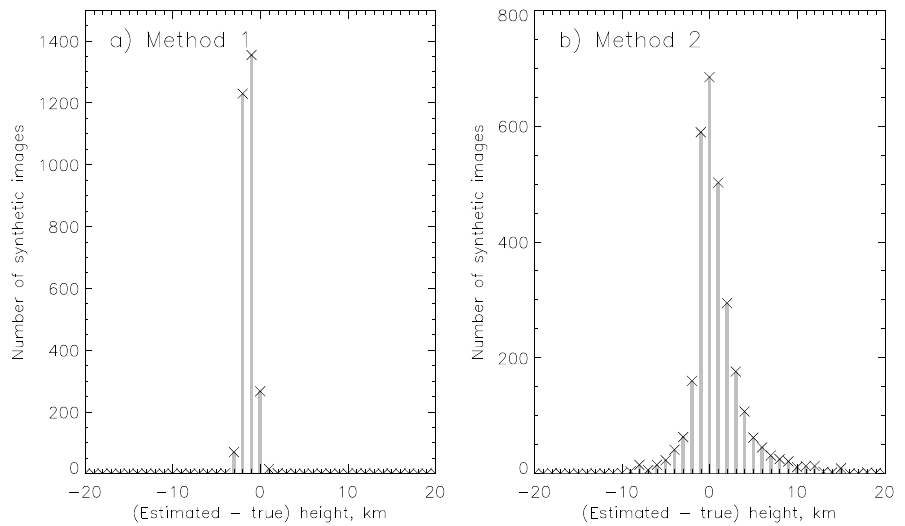
Fig. 10. As Fig. 8 but showing results from only N–S and E–W aligned arcs for (a) method 1 (b) method 2. Standard deviations: (a) 0.7, (b) Fig. 10. As figure 8 but showing results from only N-S and E-W aligned arcs for a) method 1 b) method 2. Standard deviations: a) 0.7, b) 2.9.